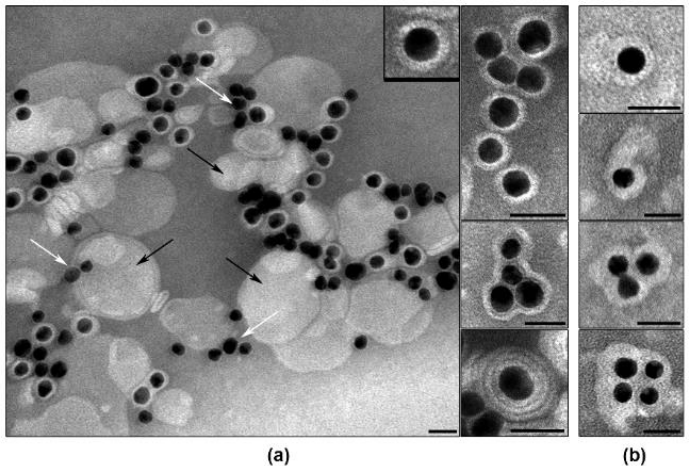
Figure 8. Suspension of nanospecies obtained after enveloping of siRNA-AuNPs (cores) with LM1. Black arrows show “empty” lipid particles without core, white while arrows show “naked” cores. Insert: A particle of siRNA-Au-LM1 at high magnification. Contrasting with: ( a ) PTA (pH 3.0); and ( b ) uranyl acetate. Length of scale bars correspond to 25 nm.